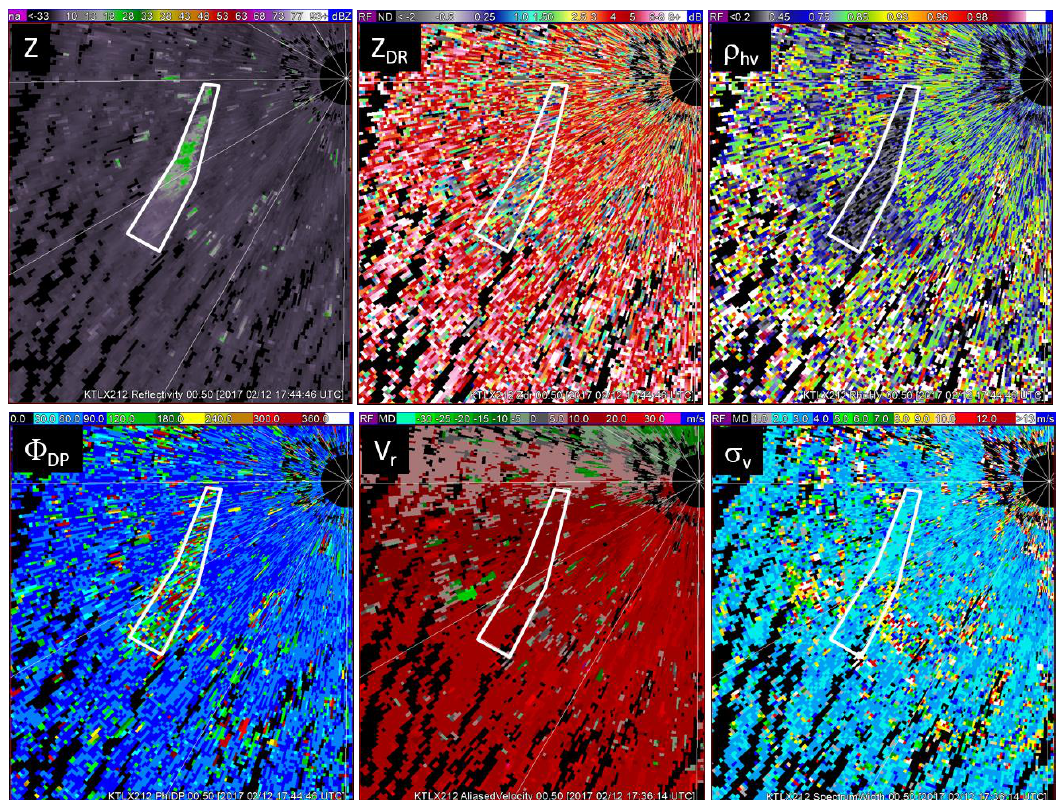
Figure 1. Fields of reflectivity, di ff erential reflectivity, correlation coe ffi cient, di ff erential phase, Doppler velocity, and spectrum width. The radar is the Weather Surveillance Radar 1988 Doppler (WSR-88D) (Twin Lakes, Oklahoma City, OK, code designation KTLX), elevation angle is 0.5 ◦ , and the date is February 12, 2017 time 17:45:59 UTC. The color bars indicate dBZ units for reflectivity Z , dB for differential reflectivity Z DR , degrees for differential phase Φ DP , and m s −1 for Doppler velocity v r and spectrum width σ v . The polygons contain data from the plume.